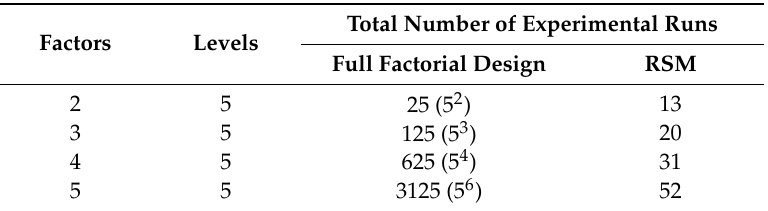
Table 1. Di ff erence in number of experimental runs between full factorial design and response surface methodology (RSM)